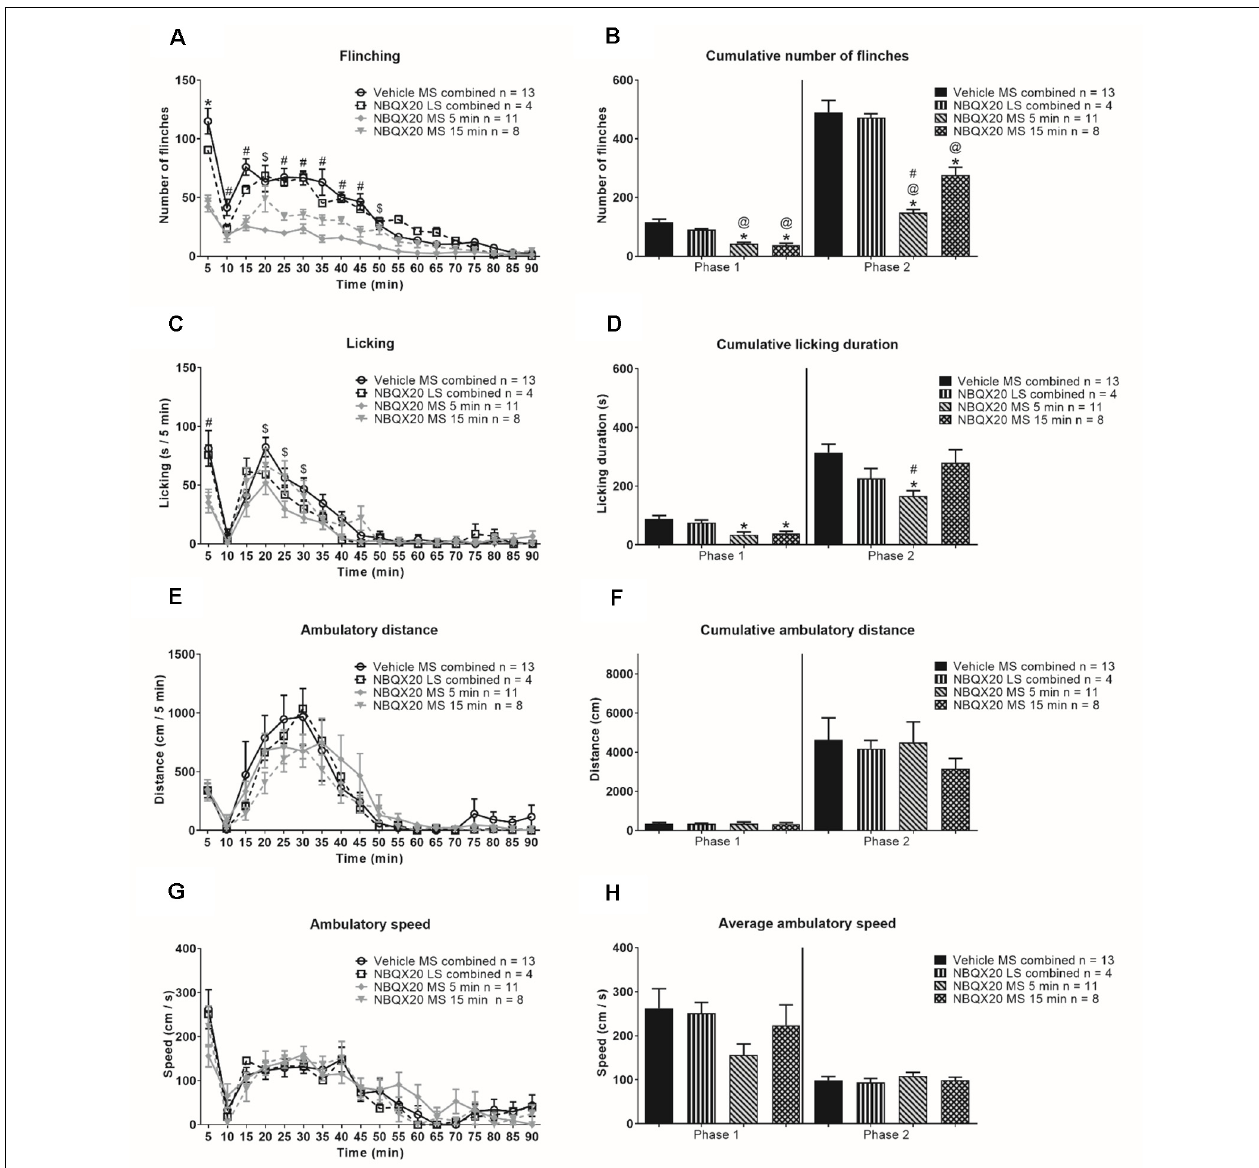
FIGURE 7 | Intraseptal microinjection of NBQX selectively attenuates formalin-induced flinching and licking. The figure illustrates the time course effect of intraseptal NBQX (20 µ g/ µ l, 0.5 µ l; ‘NBQX20’) on formalin-induced behaviors. Formalin (1.25%, 0.1 ml) was microinjected into the right hind paw at either 5 or 15 min after microinjection of NBQX. The time of formalin injection was taken as 0 min. The nomenclature illustrated on the plots is as follows: treatment (vehicle or NBQX20), site of injection (MS or LS), and time of drug microinjection preceding formalin injection (5 min, 15 min, or ‘combined’ when 5- and 15-min groups are combined). The left panel shows the time course of the flinching (A) , licking (C) , ambulation (E) , and the ambulatory speed (G) calculated in 5-min block. The panels on the right are histograms showing the cumulative changes in behaviors in Phase 1 (0–5 min) and Phase 2 (11–60 min) of the formalin test (B,D , and F) . The histogram in (H) shows the average speed of ambulation in the two phases. The figure shows that NBQX20 microinjection in MS, but not LS, attenuated formalin-induced nociceptive behaviors with a stronger effect of microinjection of NBQX20 5 min before formalin injection. However, ambulation was not affected (E) . For clarity, only time points that showed a significant effect of NBQX compared to vehicle are demarcated on the graphs. Data are mean ± S.E.M. Significant differences ( p < 0.05): Time course: *vehicle vs. NBQX20 MS 5 min, NBQX20 MS 15 min and NBQX20 LS combined, # vehicle vs. NBQX20 MS 5 min and NBQX20 MS 15 min, $ vehicle vs. NBQX20 MS 5 min, two-way RM ANOVA followed by Bonferroni post hoc test. Histograms: *vs. Vehicle, @ vs. NBQX20 LS combined and # vs. NBQX20 MS 15 min, one-way ANOVA followed by Newman-Keuls post hoc test.